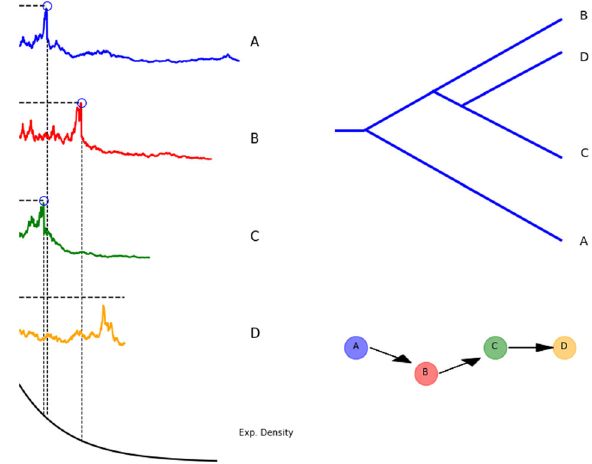
Fig. 7 An illustration of the formation of a phylogenetic tree and its underlying geography. The left-hand side shows times at which the upper population barrier is reached, prompting a segment of the population